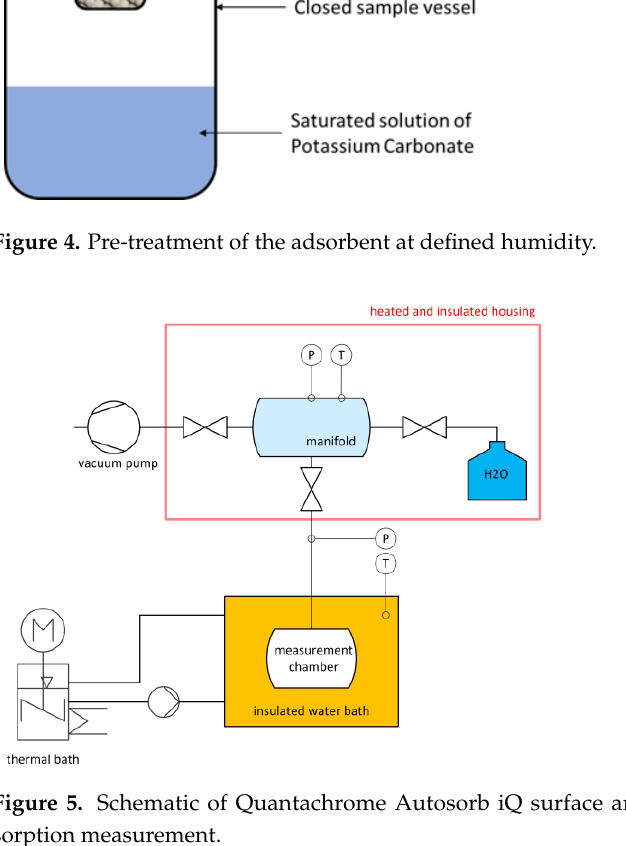
Figure 4. Pre-treatment of the adsorbent at defined humidity.